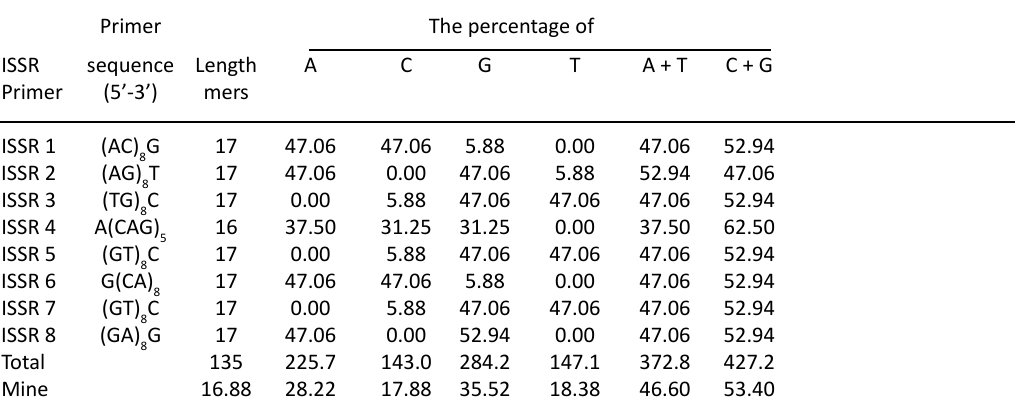
Table 2. The percentage of nucleotide sequences, used for molecular characterization Primer The percentage of ISSR